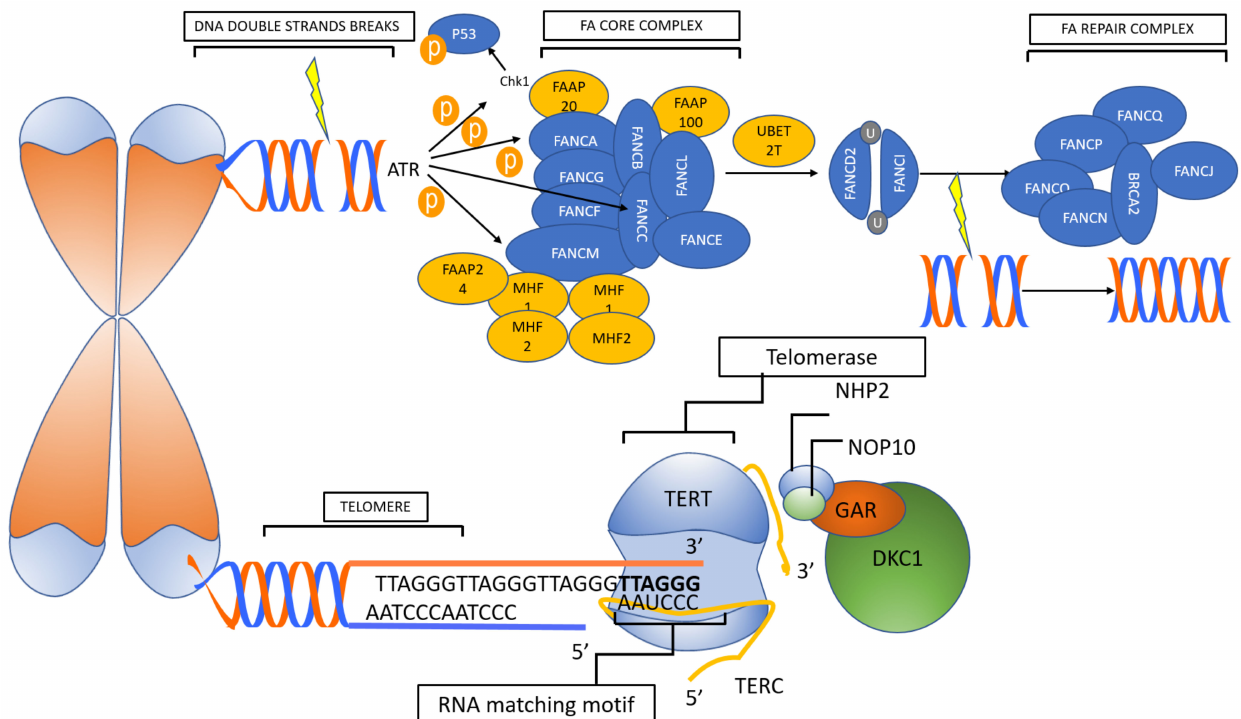
Figure 3. Telomerase function and DNA damage response system. Telomerase is the ribonucleoprotein responsible for the preservation of telomeres. Under normal condition, telomerases are able to counterbalance the physiological nucleo-tide loss of the chromosomal telomeric portion, and therefore prevents chromosome end-to-end fusions and rearrange-ments. In parallel, DNA damage response manages lesions and mutations occurring in non-telomeric portions of the DNA double strands. Primary telomeropathies are directly related to telomerase dysfunction, whereas secondary telom-eropathies are related to the misfunction of the DNA damage response proteins. For details, see text section on telomer-opathies. FA, Fanconi